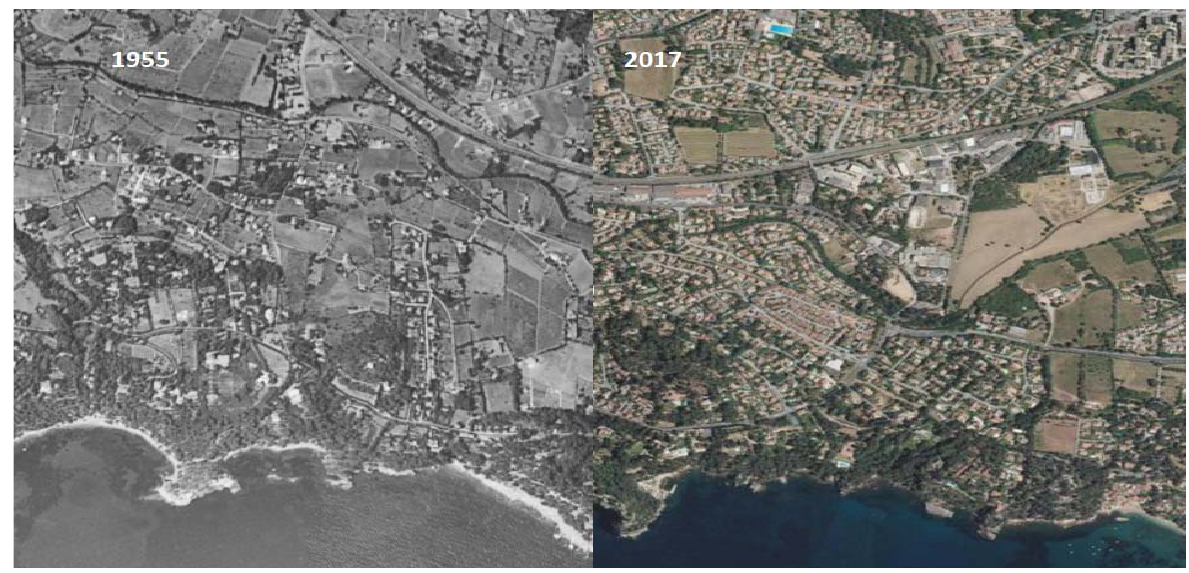
Figure 9. The evolution of urbanization between 1955 and 2017 in the municipality of La Grade (Var department). Source: